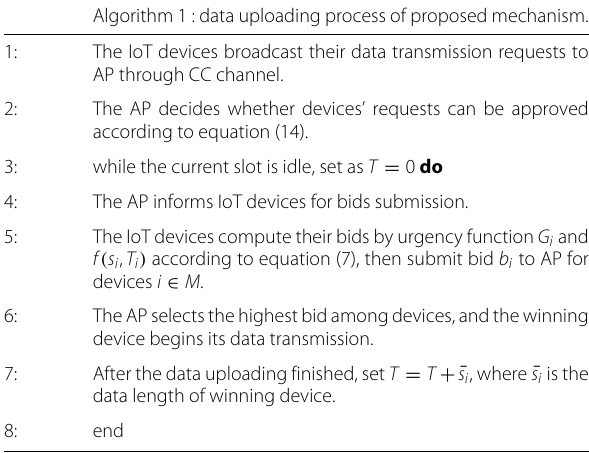
Table 2 Data uploading process of the proposed mechanism Algorithm 1 : data uploading process of proposed mechanism.